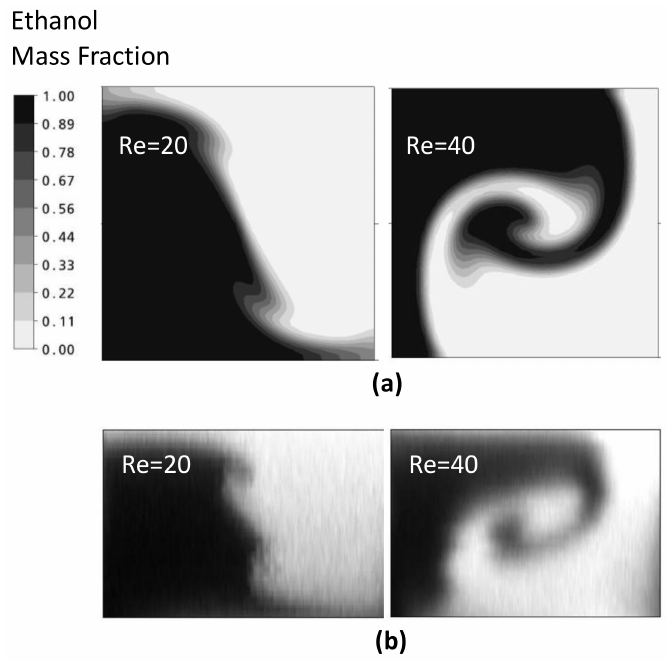
Figure 5. Comparison of the simulation and experimental results for the vortex micro T-mixer: ( a ) numerical results for the mass fraction distribution on y-z plane and ( b ) experimental results for the cross-sectional image